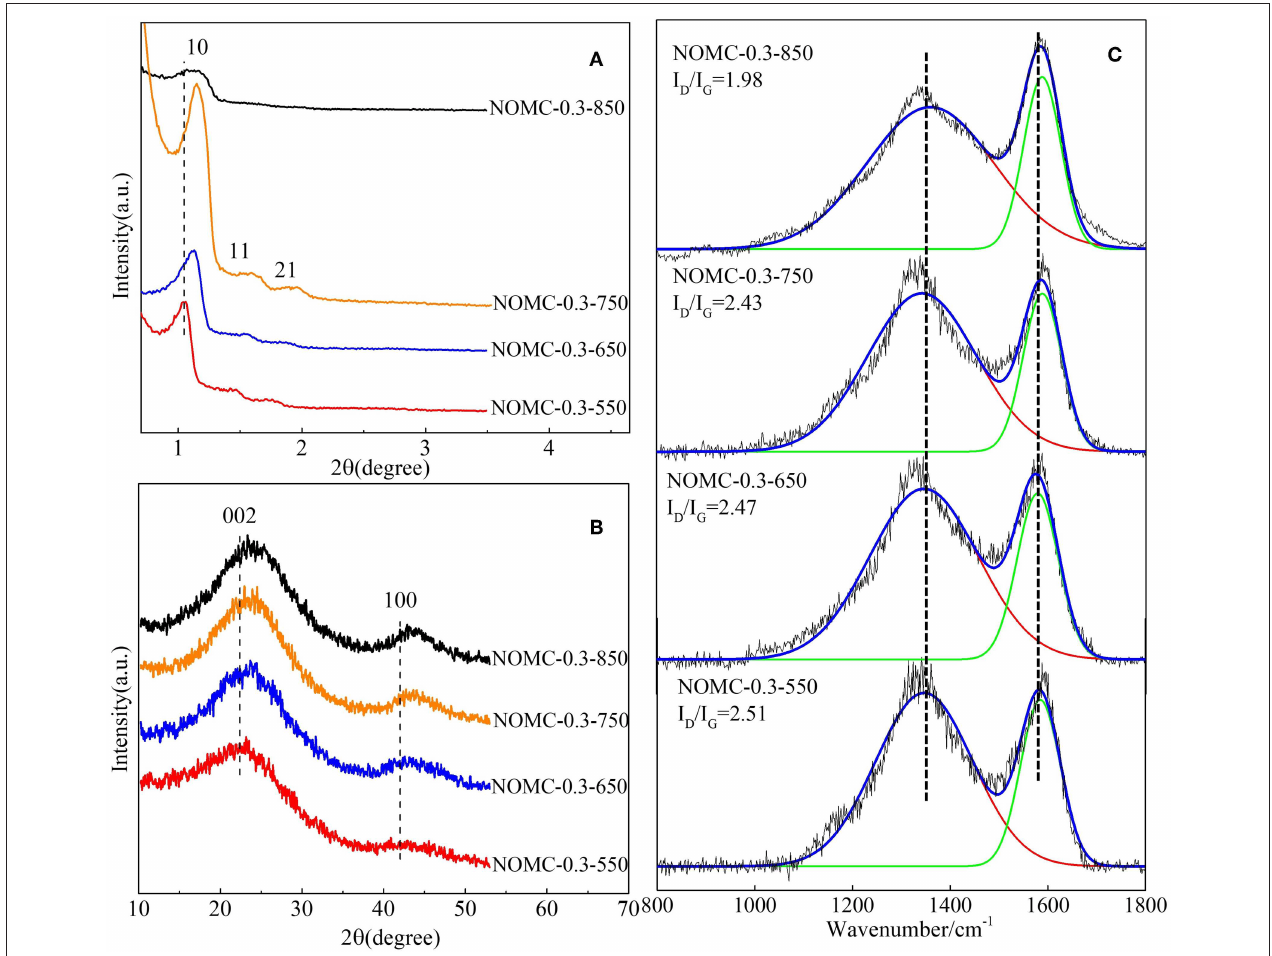
FIGURE 3 | Small–angle (A) and wide–angle (B) XRD patterns and Raman spectra (C) of NOMCs, ordered mesoporous carbon with various pyrolysis